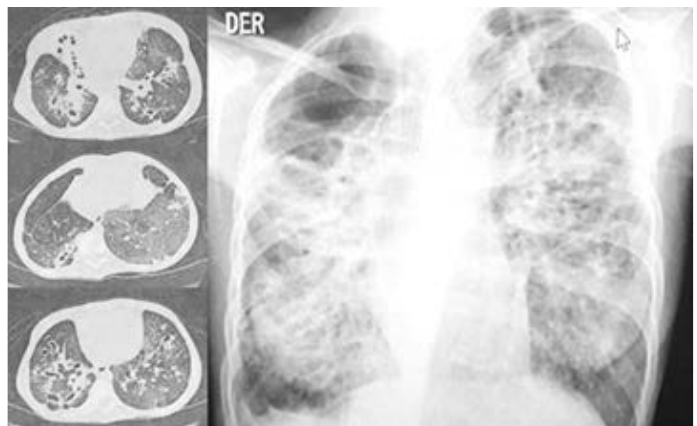
Fig. 1. CT-scan and Chest X-ray of April 2020, with described